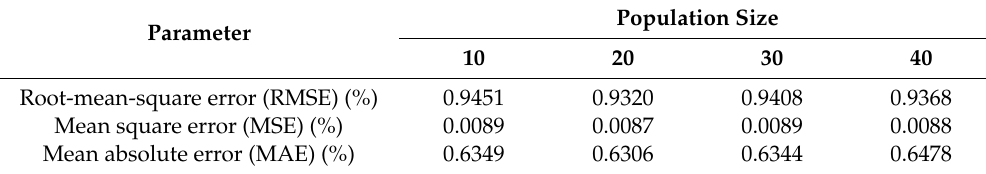
Table 2. Statistical indices at di ff erent population sizes in hybrid